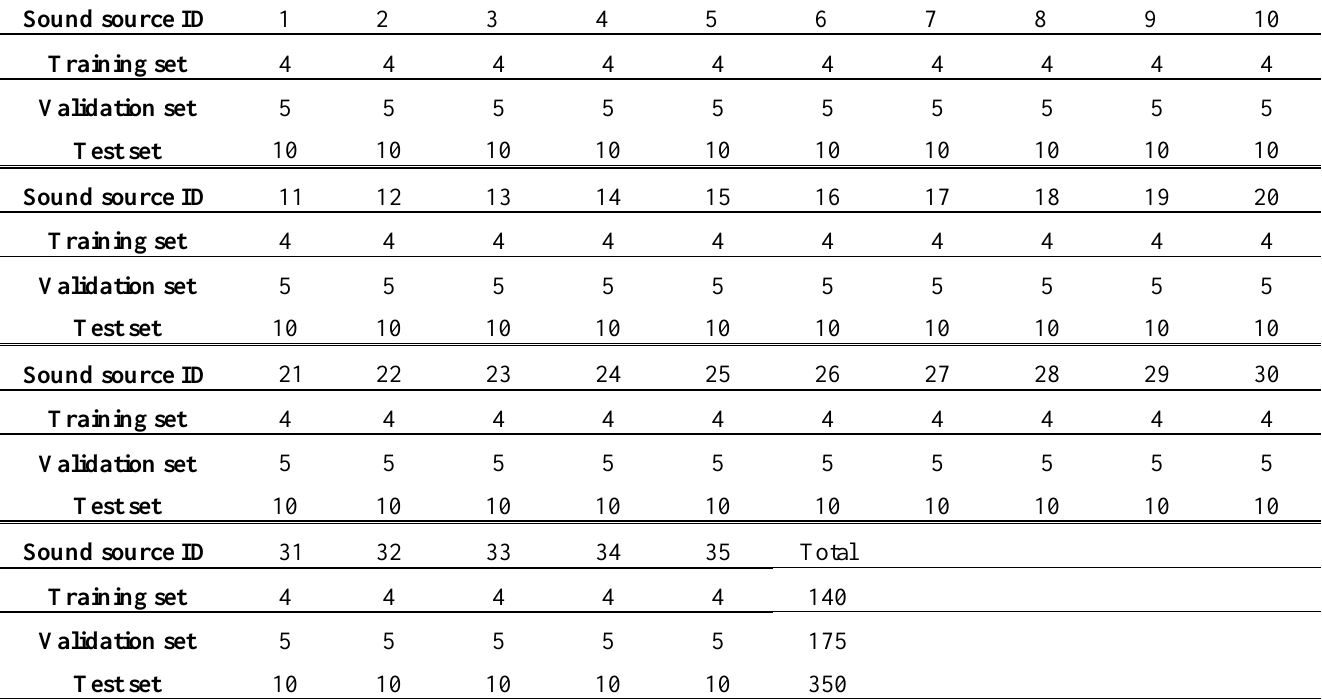
Table 3. Detailed aggregation of training set, validation set and test